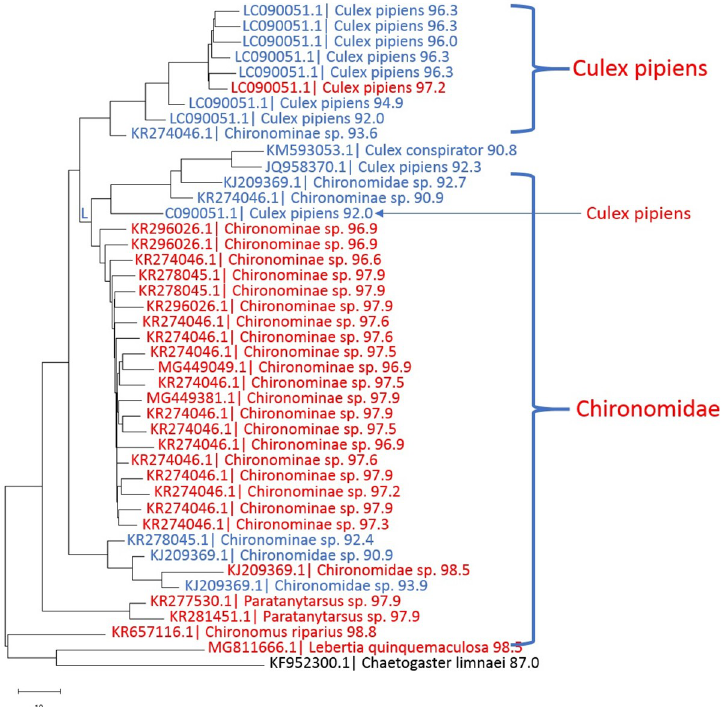
Fig 4. Neighbor-joining tree of non-mite DNA OTUs in representative Lebertia quinquemaculosa mite of PCR products amplified with mLep/LCOI primers-Illumina adapter primers. Each branch is labeled with the “best hit” accession ID in GenBank, taxon name, and the percent identity of the OTU to its best hit. Mostly chironomid and mosquito DNA in a specimen of L . quinquemaculosa . Color code: red, identities > 96.5%; blue, identities 90% - 96.5%; black, identities 80% - 90%. All OTUs represent > 10 sequences.